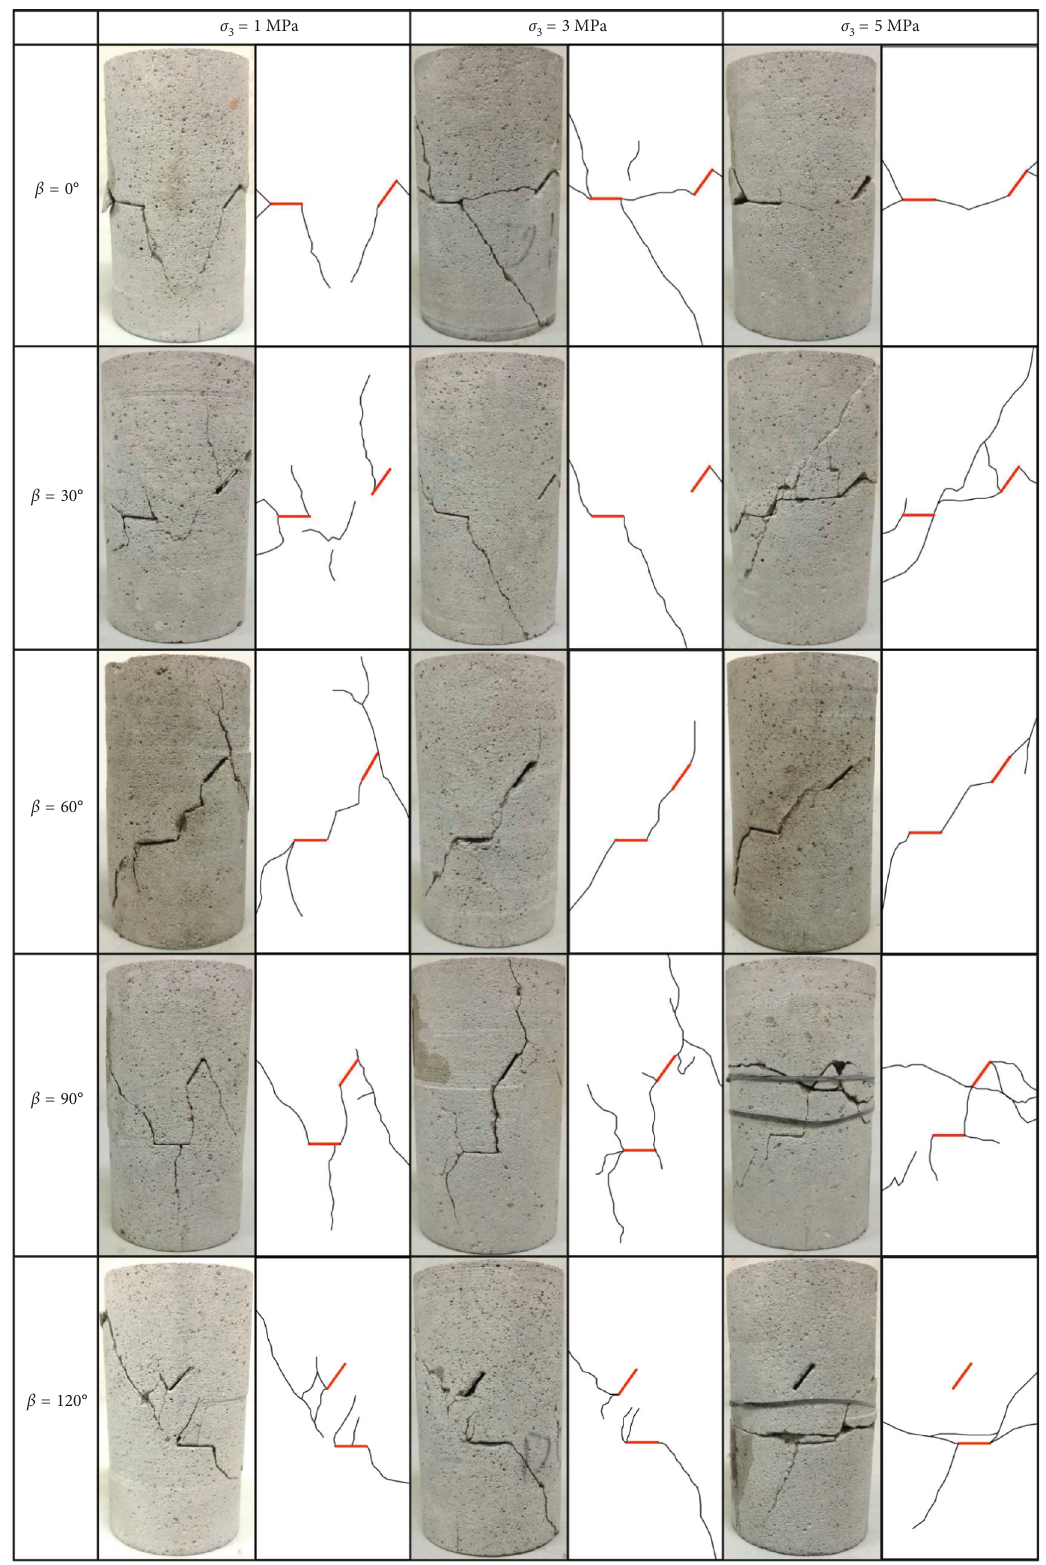
Figure 8: Failure modes of the specimens with a geometry of 20-0-60- β and with different bridge